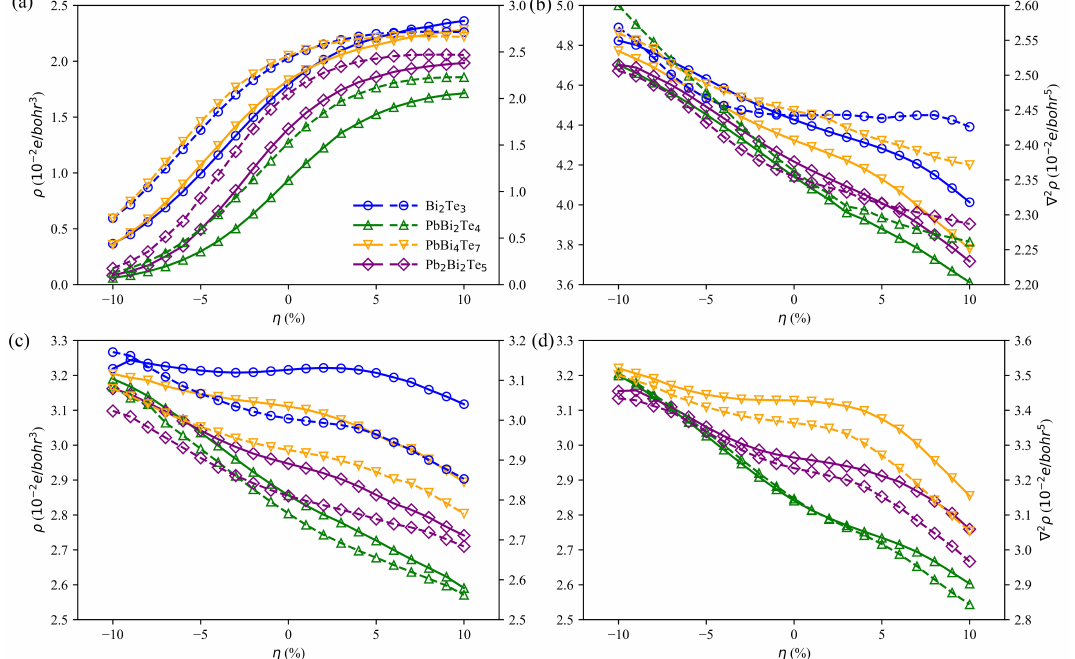
Figure 10. Charge density, ρ (solid lines), and charge density Laplacian, ∇ 2 ρ (dashed lines), at various bond critical points (b1 in ( a ), b2 in ( b ), b3 in ( c ) and b4 in ( d )) for Bi 2 Te 3 , PbBi 2 Te 4 , PbBi 4 Te 7 and Pb 2 Bi 2 Te 5 w.r.t. strain. The positions of b1, b2, b3 and b4 are defined in Figure